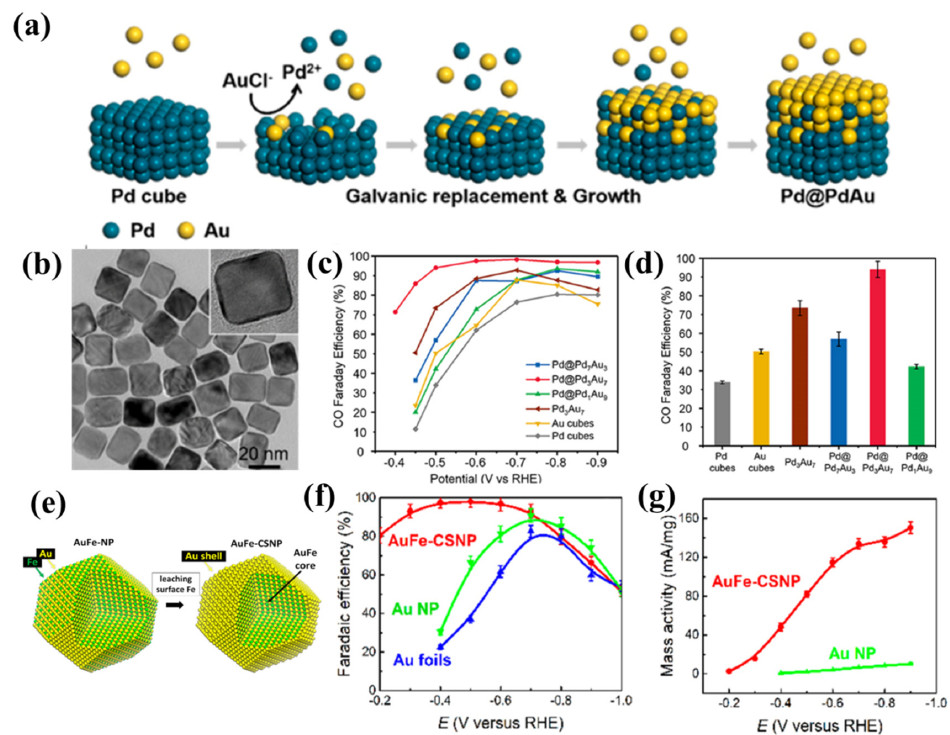
Figure 11. ( a , b ) Schematic, TEM images and HR-TEM images of Pd@Pd 3 Au 7 NCs. ( c ) CO FE as a function of potential. ( d ) CO FE of di ff erent catalysts at − 0.5 V vs. RHE. Reprinted with permission as a function of potential. ( d ) CO FE of different catalysts at − 0.5 V vs. RHE. Reprinted from Ref. [129]. Copyright 2019, American Chemical Society. ( e ) Schematic illustration of the struc- tural evolution of Au-Fe alloy NP to Au-Fe core/Au shell NP after leaching out of surface Fe. ( f , g )